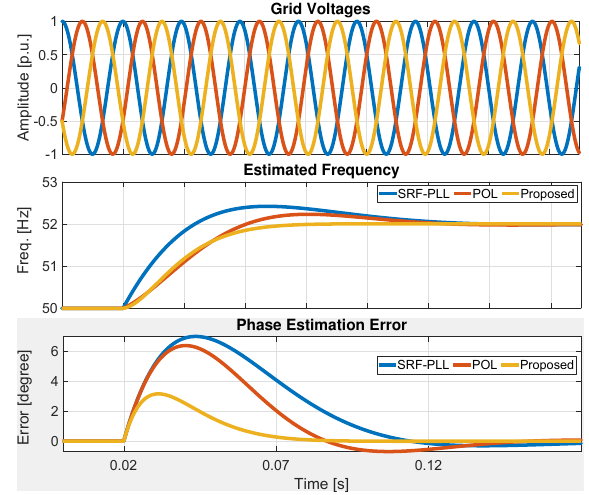
Figure 4. Comparative numerical simulation results for Test-I: + 2 Hz step change in frequency.